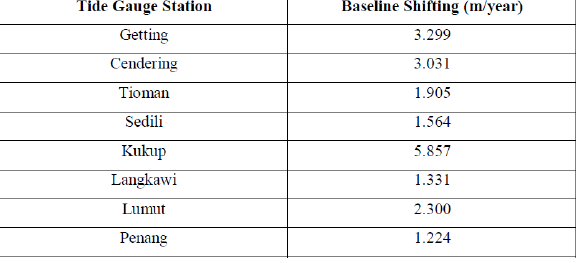
Table 5. Shifting of